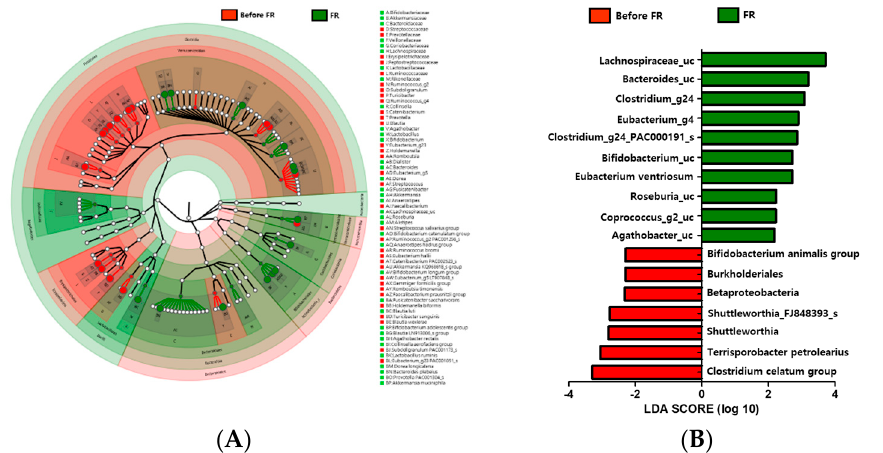
Figure 2. Genus level distribution and linear discriminant analysis (LDA) effect size (LEfSe) analysis revealed differences in the gut microbiota between the before FR and FR groups. ( A ) A cladogram of taxonomic differences between the before FR (red) and FR (green) groups. ( B ) Significant bacterial differences were found in the before FR (red) and FR (green) groups. The significant threshold of the LDA score is >2; flavonoid-rich orange juice treatment taxonomic compositions are indicated with a positive LDA (green) in the FR group and enriched taxonomic compositions are indicated with a negative LDA score (red) in the before FR group.